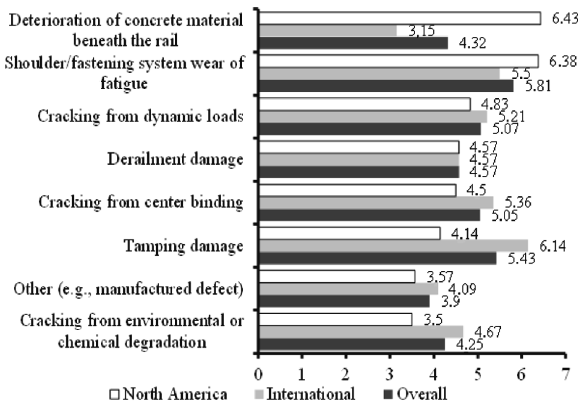
Fig. 1. Main failure causes of concrete sleeper (Dyk et al.